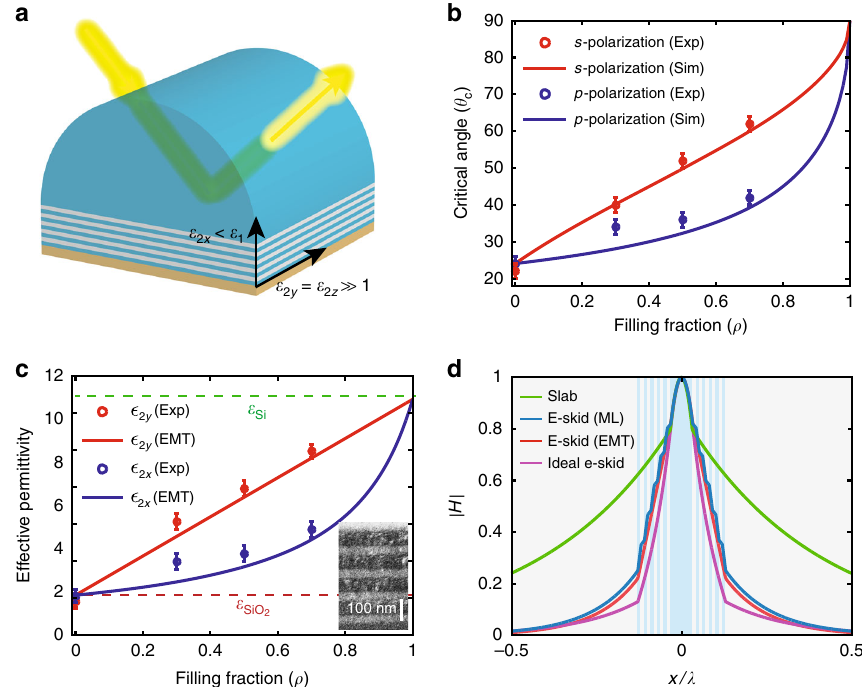
Fig. 2 Relaxed total internal re fl ection. a Schematic of the relaxed TIR experiment. We measure the re fl ection from the Si prism and Si/SiO 2 multilayer interface for both s and p polarizations at λ = 1550 nm. Multiple samples with different ρ have been fabricated. The periodicity for all samples is 100 nm and the total thickness of the multilayer is 500 nm. A 200 nm layer of tungsten is deposited on top of the multilayer (brown) to suppress the re fl ection from the air interface. b The measured critical angle for s and p polarizations vs. the silicon fi lling fraction in comparison with effective medium theory (EMT) calculations. Error bars represent the instrument limit of the measuring device. In contrast with the conventional phenomenon of TIR, observable differences between the critical angles is seen for different polarizations in agreement with relaxed TIR theory. c Retrieved effective permittivity of the multilayer from the critical angle measurements show strong anisotropy in agreement with EMT. The refractive index of Si and SiO 2 are taken to be 3.4 and 1.47, respectively, for the theoretical calculations. The inset shows the SEM image of an Si/SiO 2 multilayer with ρ = 0.5. d Normalized calculated magnetic fi eld pro fi le for the TM mode of a conventional slab waveguide compared to extreme skin-depth (e-skid) waveguides with Si/SiO 2 multilayer cladding. The blue and gray regions represent Si and SiO 2 , respectively. The core size, Λ , and ρ are 100 nm, 30 nm, and 0.5, respectively. The multilayer anisotropic claddings strongly affect the decay of the evanescent wave in the cladding. The practical multilayer structure performs close to an ideal anisotropic case ( ε 2 x ¼ ε and ε 2 z ¼ ε SiO 2 Si